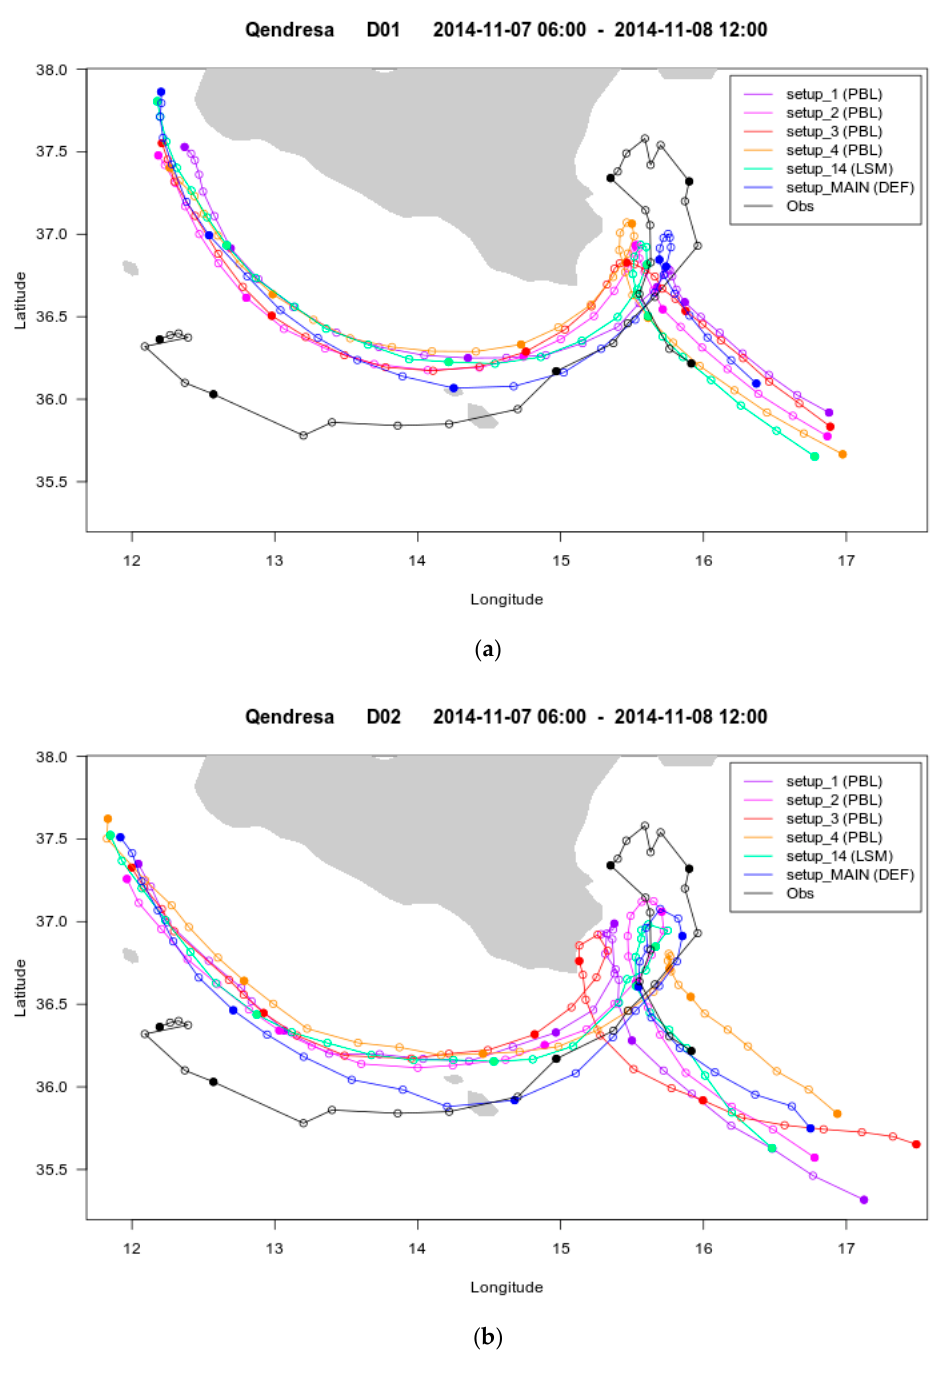
Figure 6. Trajectories of the Tropical-Like Cyclones (TLC) from 7 November at 06:00 UTC to 8 November at 12:00 UTC (depicted hourly) as predicted from the model PBL/LSM experiments in the low ( a ) and high ( b ) resolution domain. The “combined” track (black line) and control run (setup-MAIN-blue line) are also shown. The position of the low-pressure center is denoted with solid dots every six hours, i.e., at 06:00, 12:00, 18:00 UTC November 7, and at 00:00, 06:00, 12:00 UTC November 8th, and with open dots in all other hours.